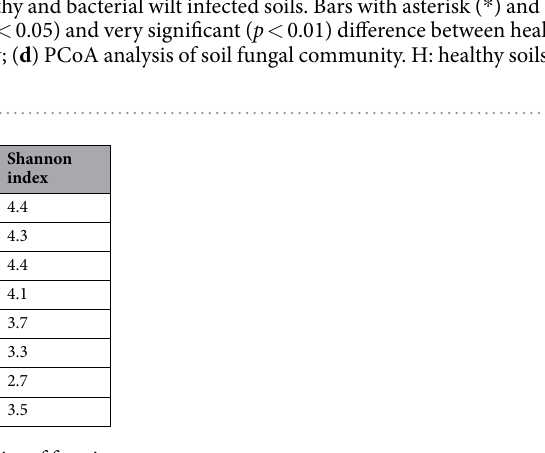
Table 5. Number of OTUs and alpha diversity of